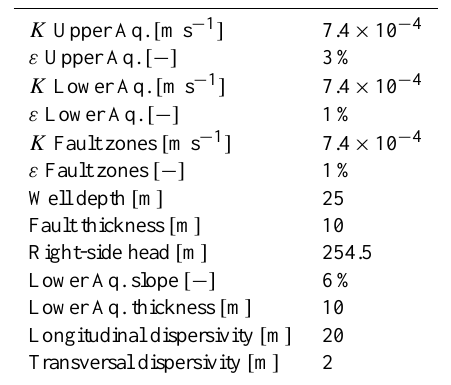
Table 1. Values of physical and geometrical parameters of the problem.